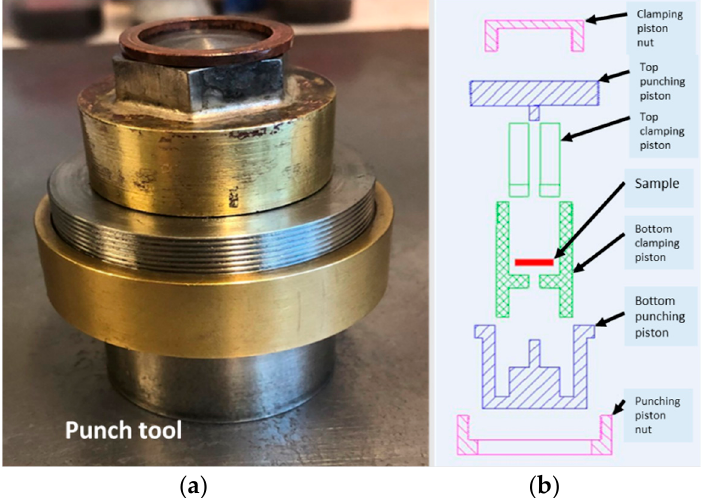
Figure 3. ( a ) Photograph of the assembled punching tool, ( b ) disassembled tool drawing showing the different pistons of the tool.